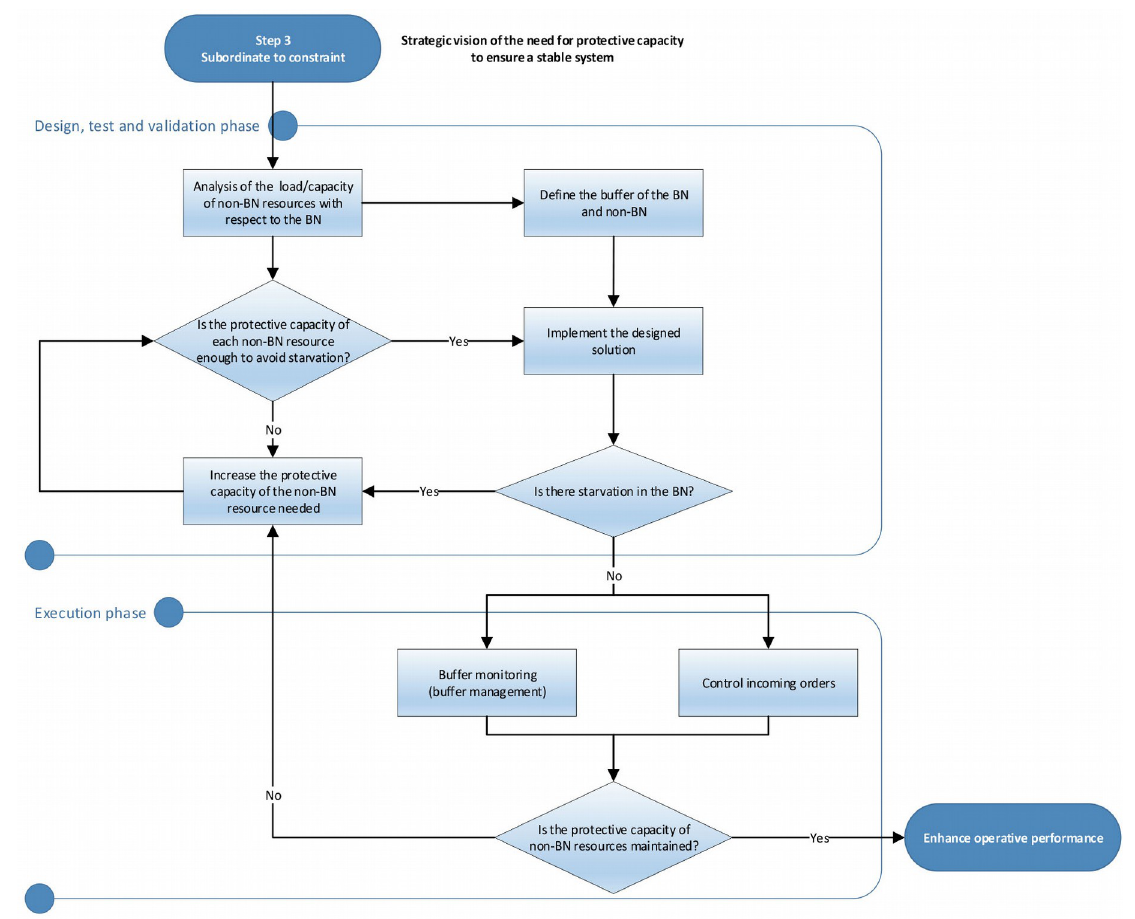
Figure 9. Implementation process of step